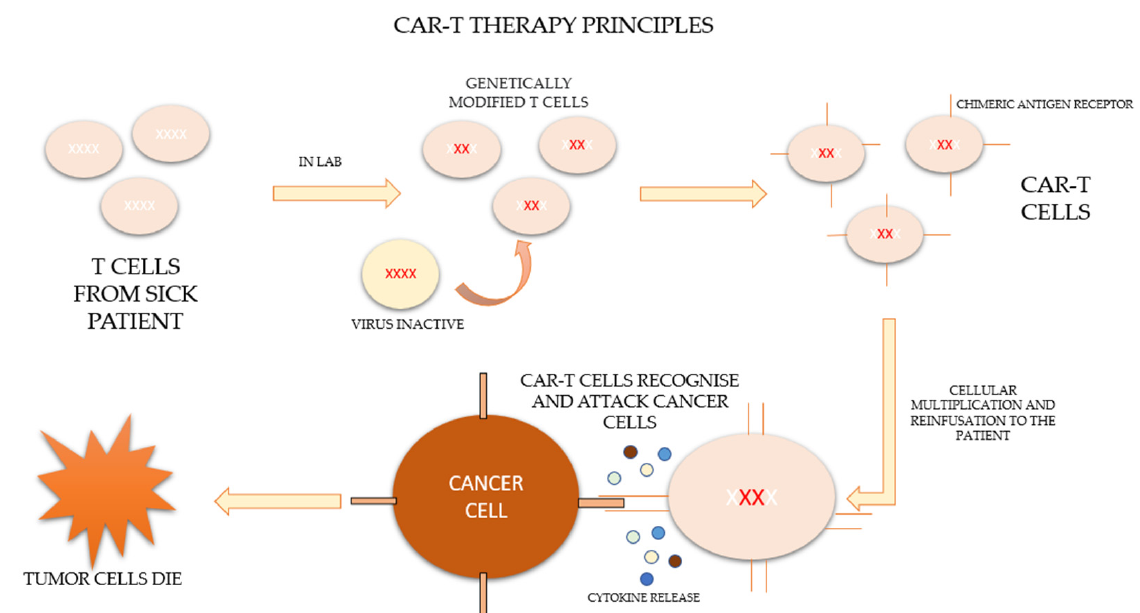
Figure 1. Principles of CAR-T therapy.